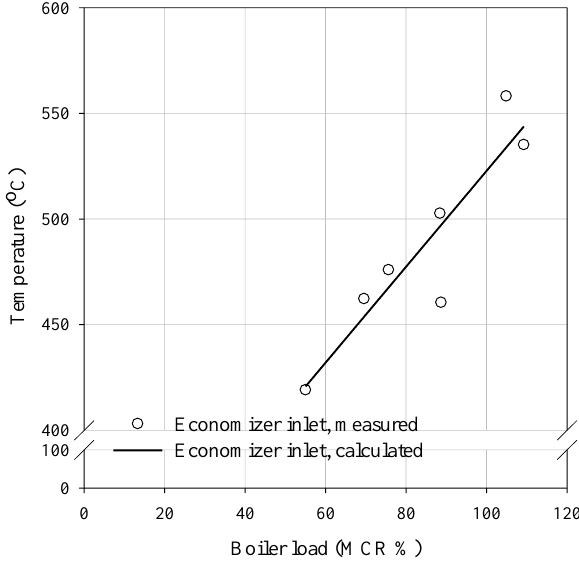
Figure 8. Measured and calculated flue gas temperature at the economizer inlet.